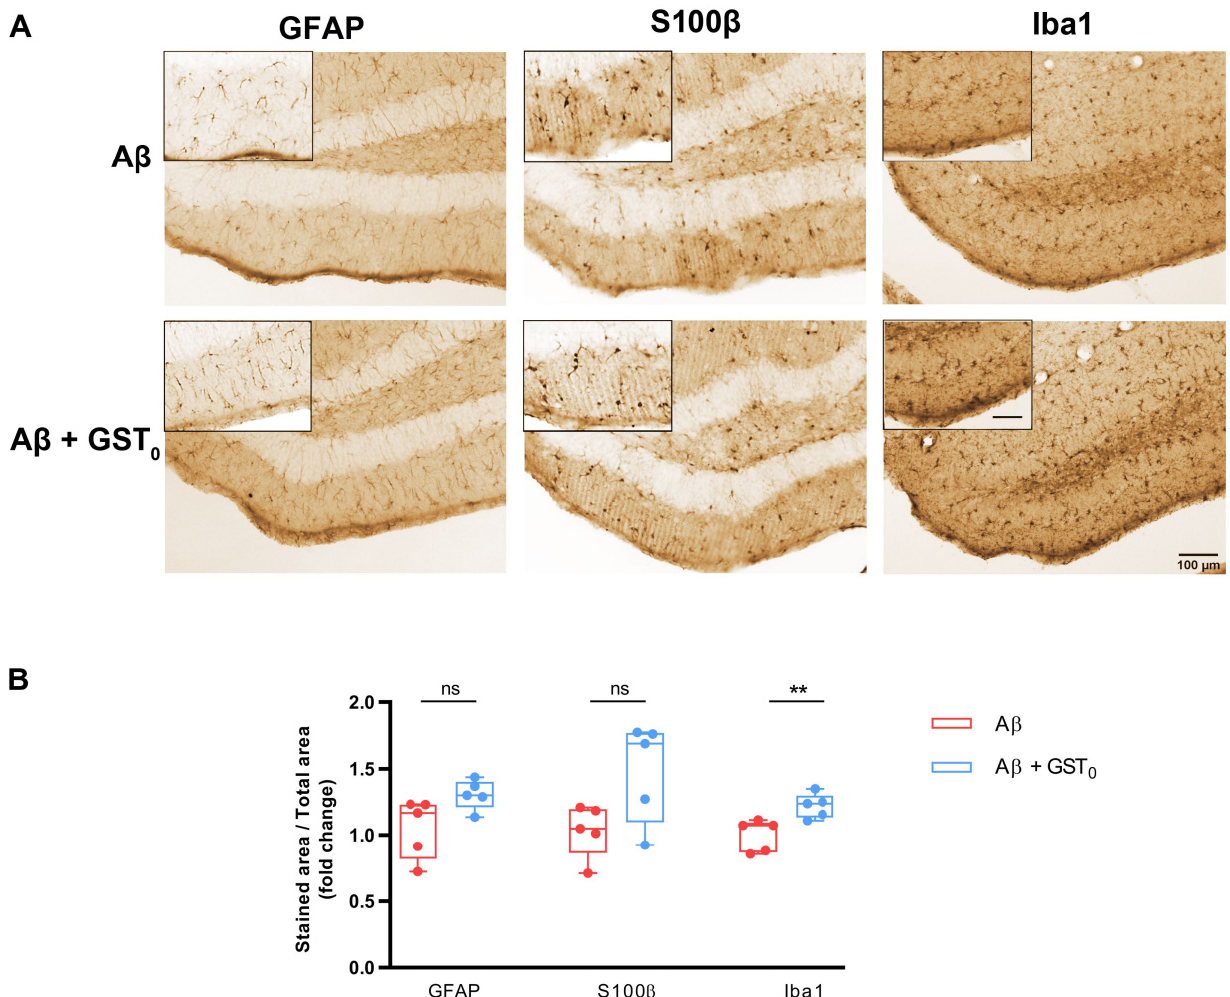
Figure 3. GST 0 polypeptide is ineffective in preventing gliosis in the DG of A β -injected mice. ( A ) Coronal sections of mouse brains were immunostained by DAB assay 7 days post-injection with A β and A β + GST 0 . Photomicrographs show GFAP and S100 β immunolabeling in astrocytes and Iba1 immunolabeling in microglia of the dentate gyrus. Scale bar: 100 µ m and Scale bar in zoom is 50 µ m. It is included in caption: 50 µ m. ( B ) Box plot graphs show quantitative analysis of labelled areas for GFAP, S100 β and Iba1 under A β and A β + GST 0 in the DG. Data are presented as the mean ± S.E.M. Fifteen slices from five animals were analyzed per condition. ns: non-significant; ** p < 0.01 compared with A β -injected mice; unpaired Student’s